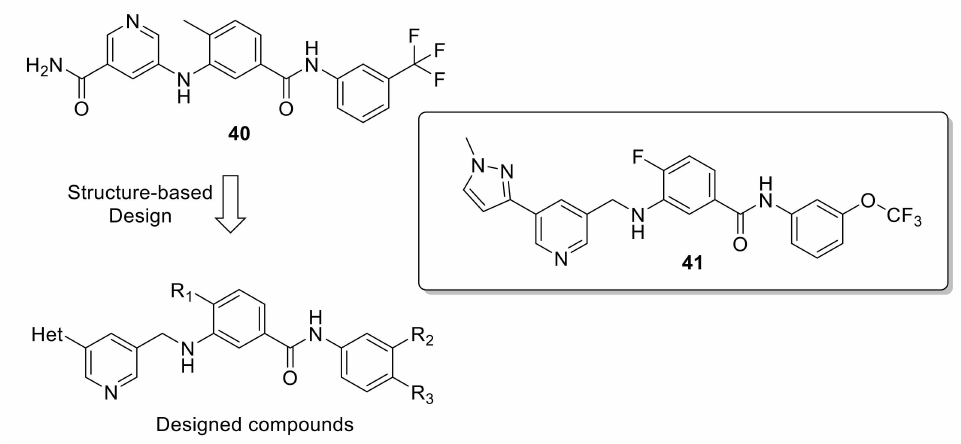
Figure 17. Structural modifications to compound 40 and chemical structure of compound 41 .